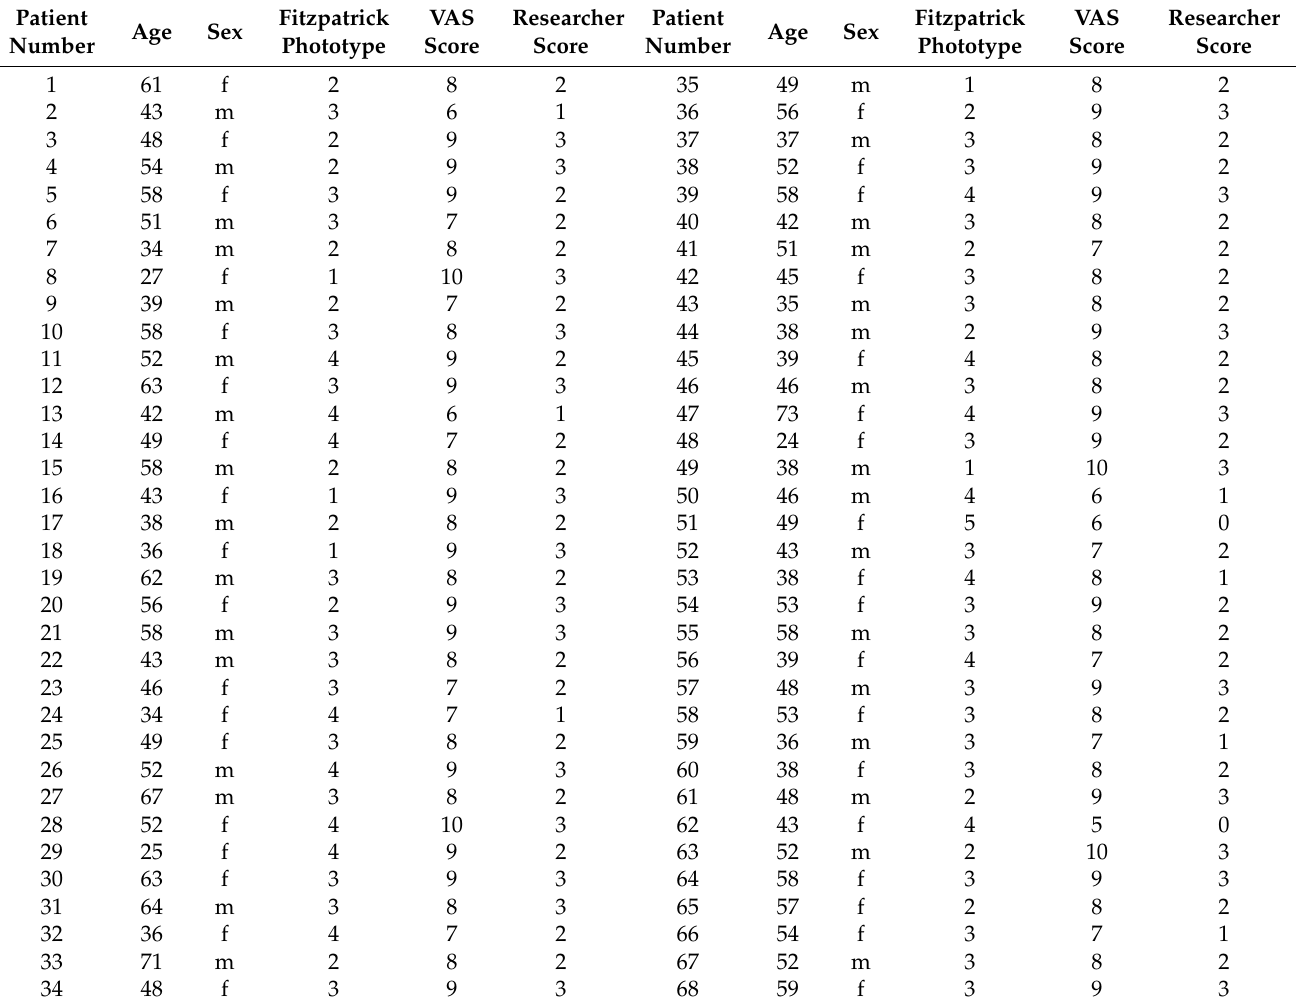
Table 1. Patient